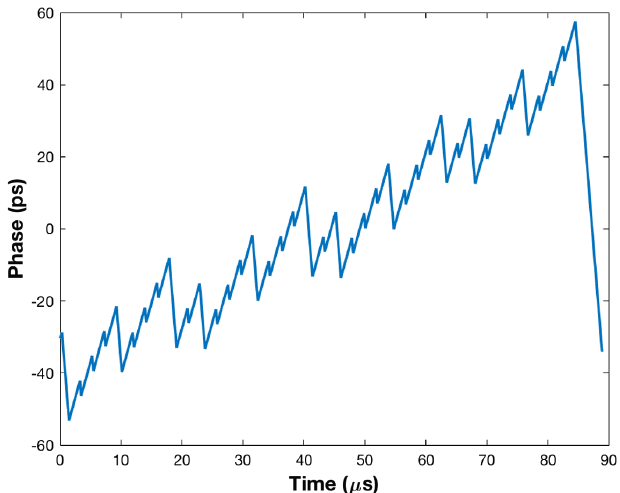
FIG. 5. Calculated cavity phase modulation for HL-LHC filling pattern and beam parameters. 2748 bunches, 2 . 2 × 10 11 protons per bunch, 7 TeV, 16 MV rf voltage, 4 . 4 μ s long abort gap. The phase is reported in ps with respect to the 400 MHz rf